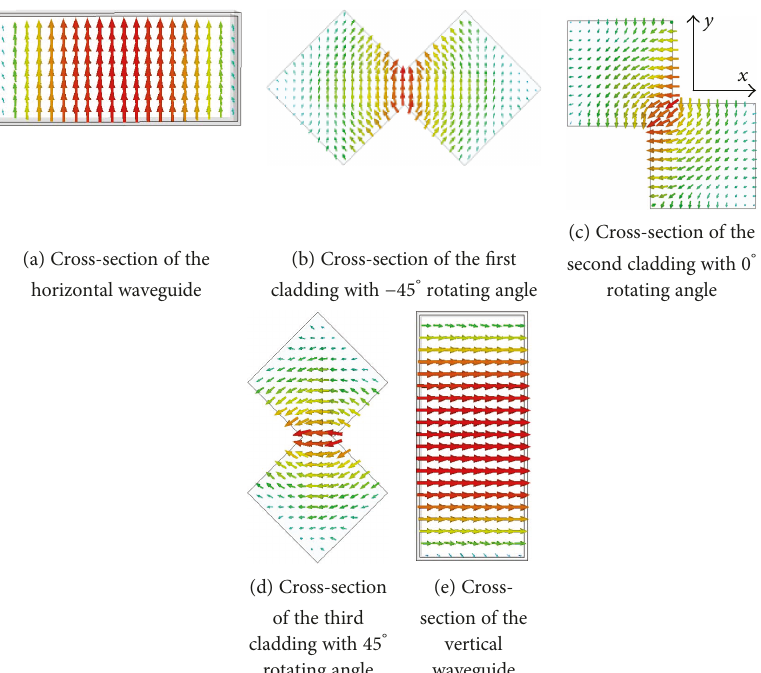
Figure 3: The electrical fi eld pattern of the in fi nite double-corner-cut waveguide (mode TE